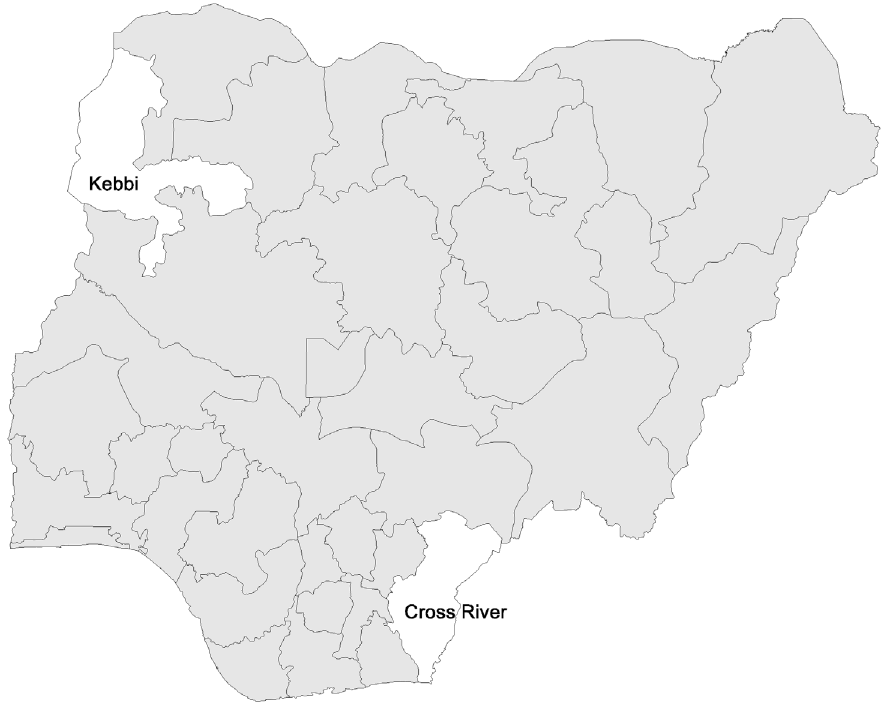
Figure 2. Map of Nigeria fieldsites.